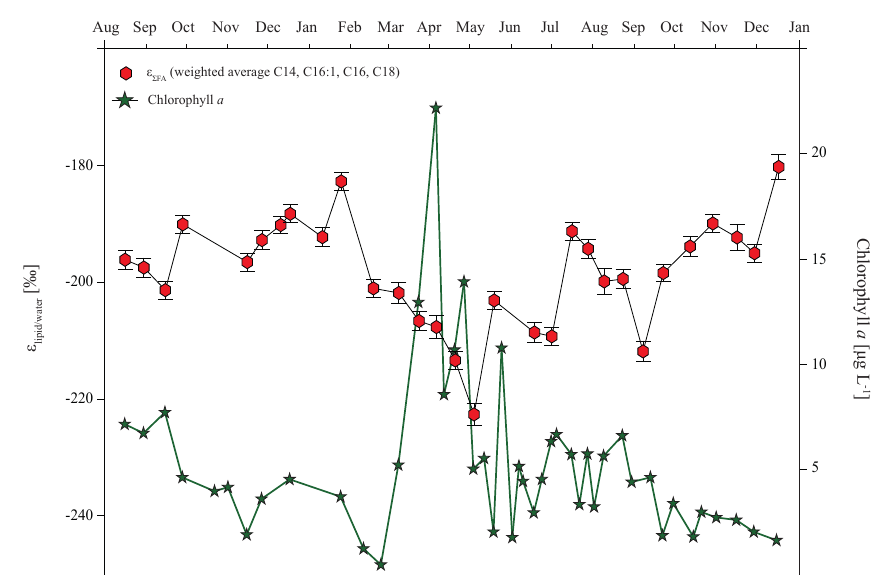
Figure 1. Values of ε FA compared to chlorophyll a concentrations. ε FA is the weighted average of n C14:0, n C16:1, n C16:0, n C18:0 fatty acids and the n C20:5 PUFA from jetty samples taken from August 2010 to December